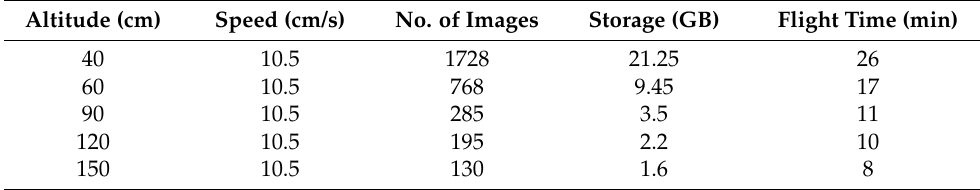
Figure 8. Minimum, suggested, and maximum speed for different altitude. Table 5. Determining number of images, storage and flight time at 10.5 cm/s. Table 3. Determining speed (cm/s) for various overlapping % at different altitude.